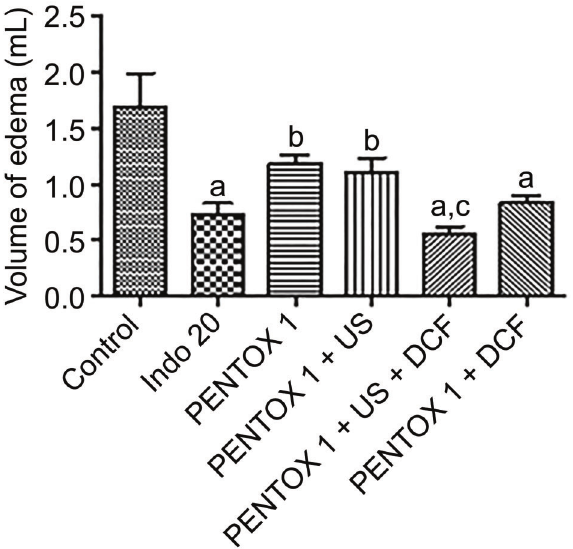
Figure 2. Means ± SE of the volume of paw edema 3 h after administration of carrageenan in diclofenac (DCF) pre-treated rats with or without ultrasound (US + DCF) and pentoxifylline (PEN- TOX 1). Indomethacin 20 mg/kg ( po ) (INDO 20) was used as reference drug. a P o 0.05, b P o 0.001 vs control; c P o 0.05 vs